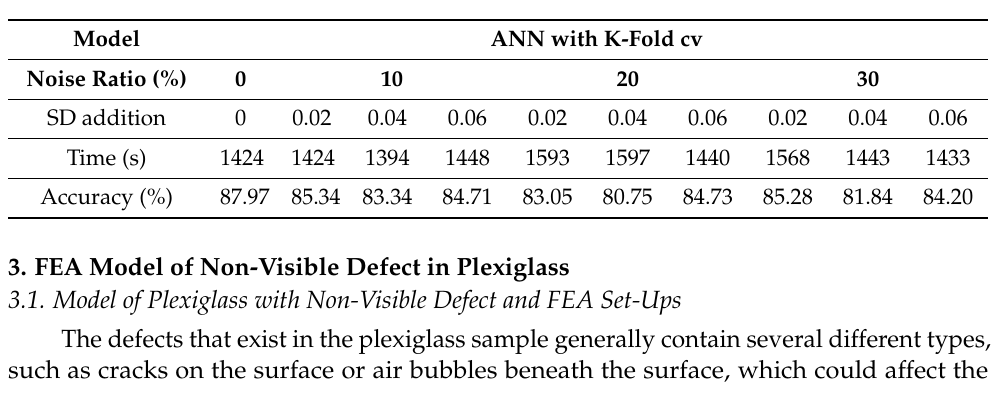
Table 8. Statistical tests of ANN with K-fold cross-validation